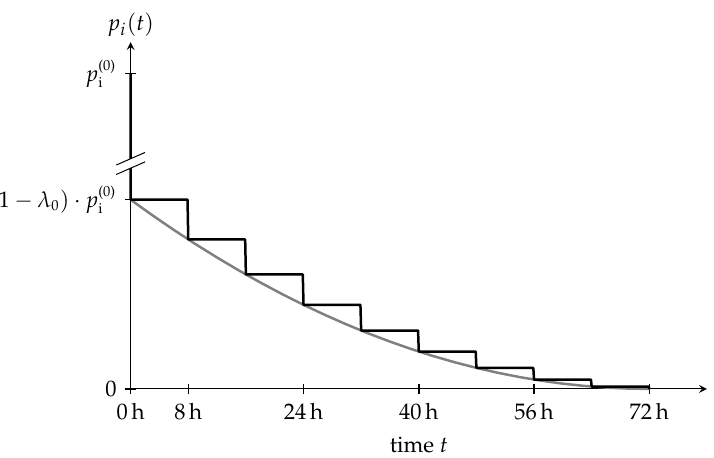
Figure 2. Stepwise stress release function p i ( t ) assumed in the finite element simulations (black curve), which is derived from the idealized parabolic stress release function, proposed by Pöttler [11] (gray